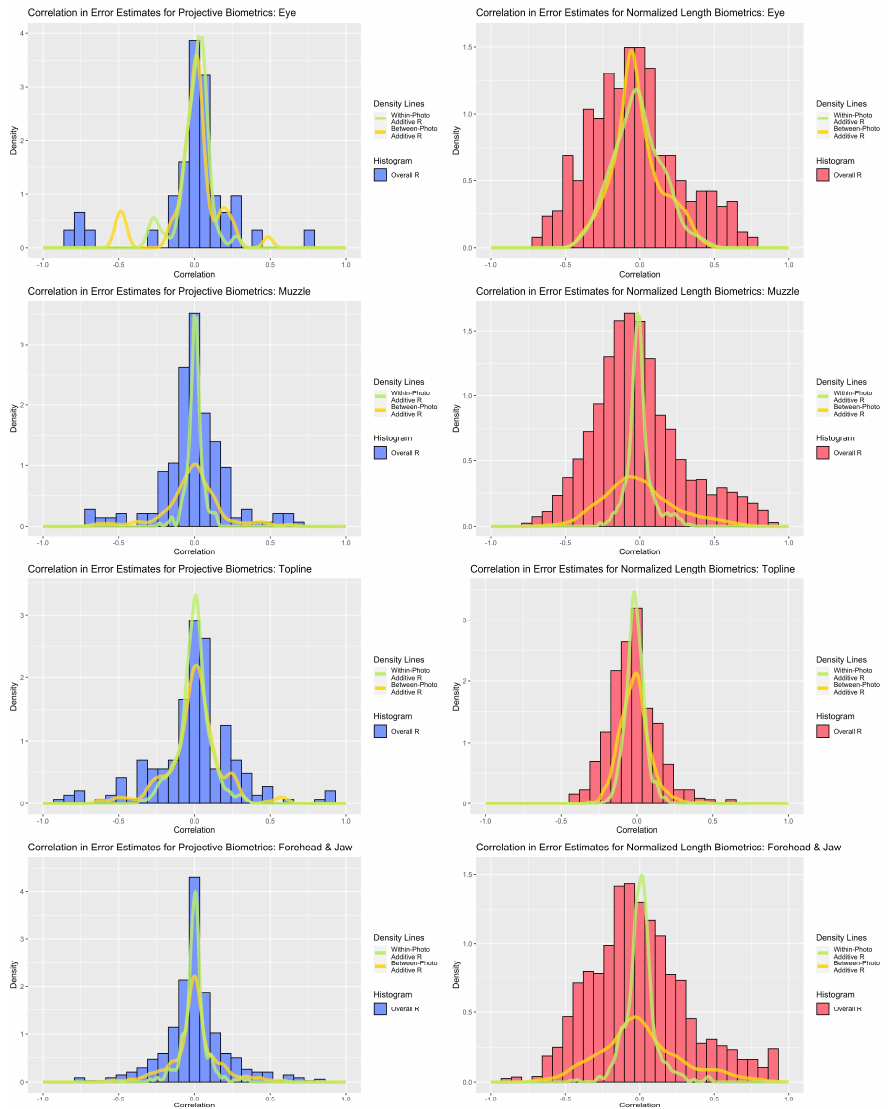
Figure 5. Comparison of correlations between overall, between-photo, and within-photo error esti- mates for normalized length (red) and projective biometrics (blue) for the four anatomical subregions (from top: eye, muzzle, topline,